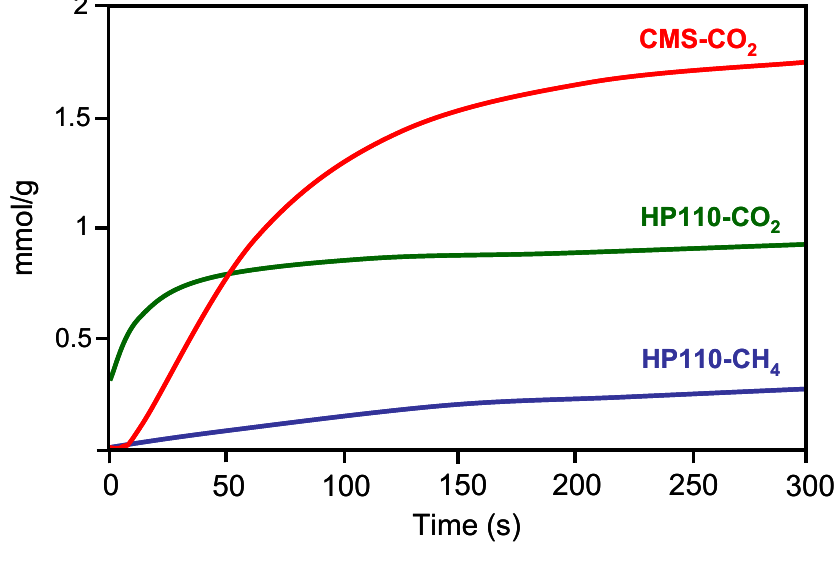
Figure 10. Kinetics of CO commercial carbon molecular sieve CMS. From reference [24], with permission from